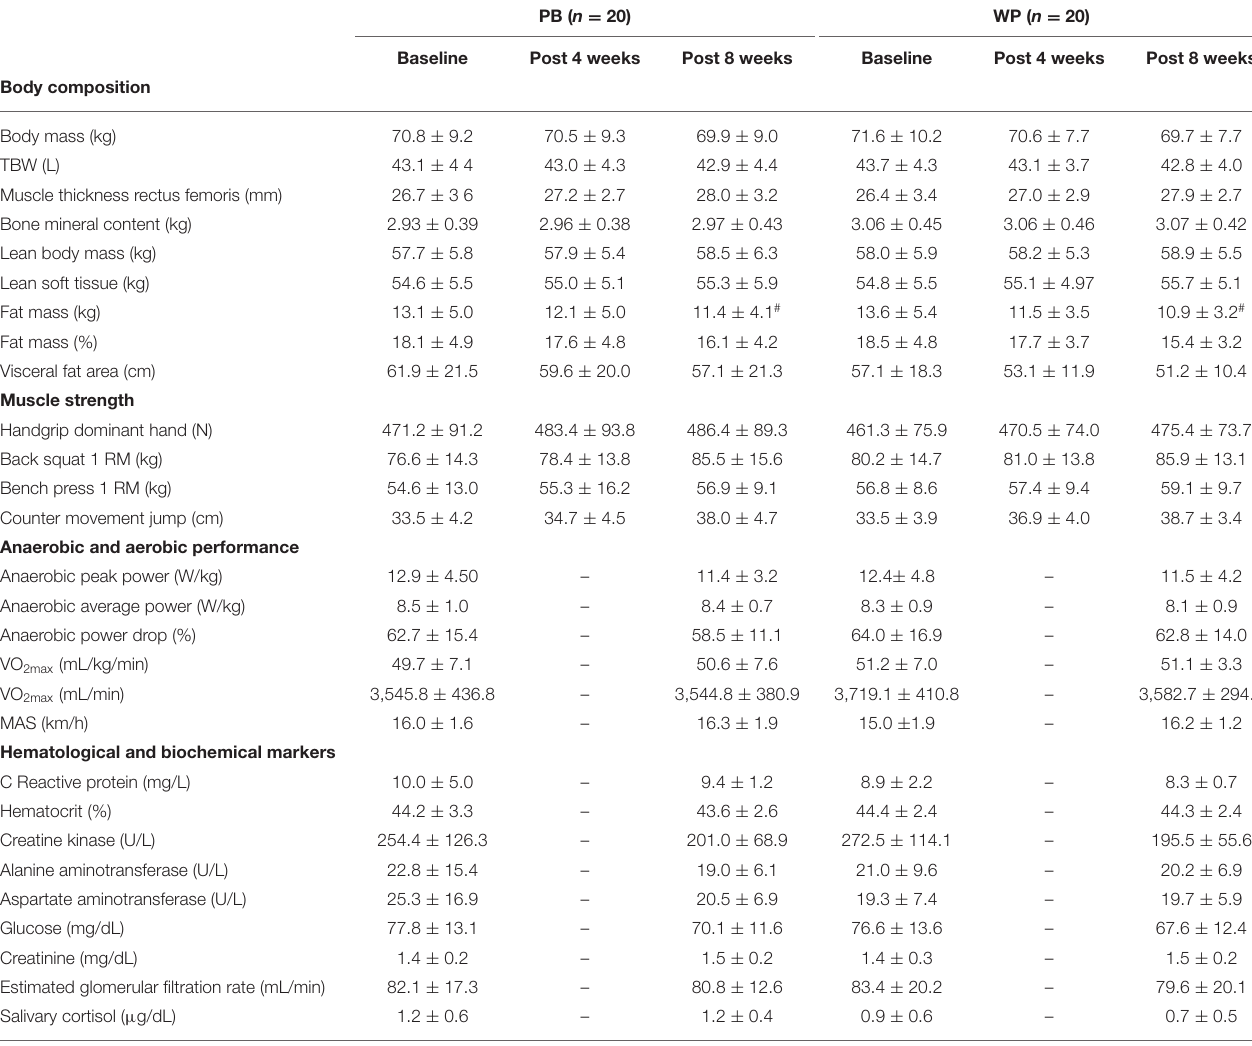
TABLE 3 | Body composition, performance, and hematological and biochemical markers at baseline and after 4 and 8 weeks of